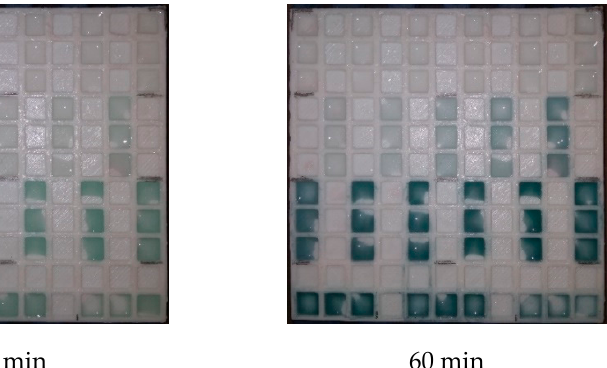
Figure 8. Effect of incubation time on the limit of detection when butyrylcholinesterase (BChE) was measured by a camera-based colorimetric assay and the measuring pad was modified with indoxylacetate. R (red) channel was used for the assay. Standard error of the mean is expressed for five independent repeats.